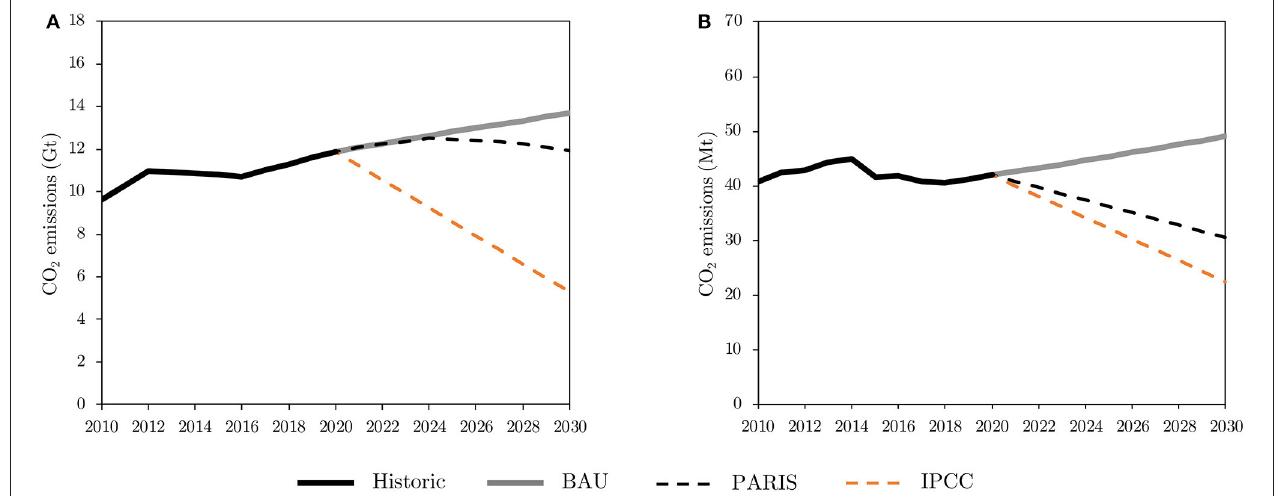
FIGURE 2 | Emission schedule under each scenario: (A) Mainland China; (B) Hong